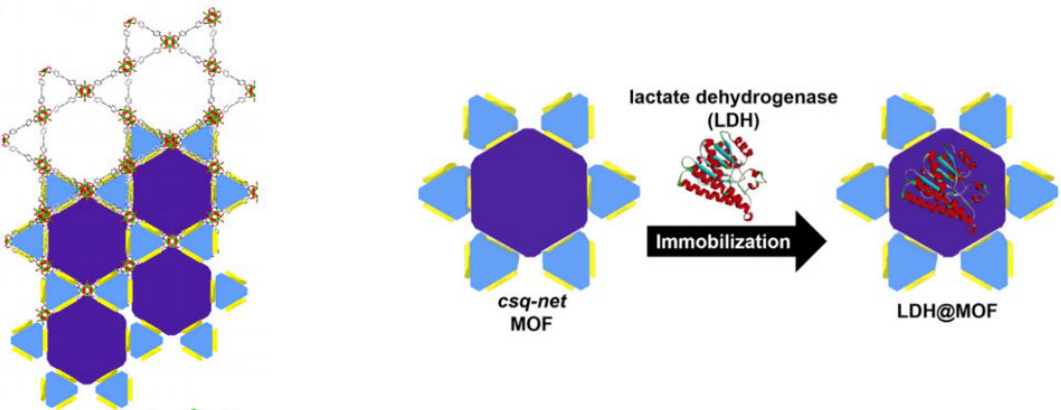
Figure 10. Representation of hierarchical pore structure of NU-1001 family, immobilisation of LDH in hexagonal channel type pore [101]. Adapted from ref. [101] with